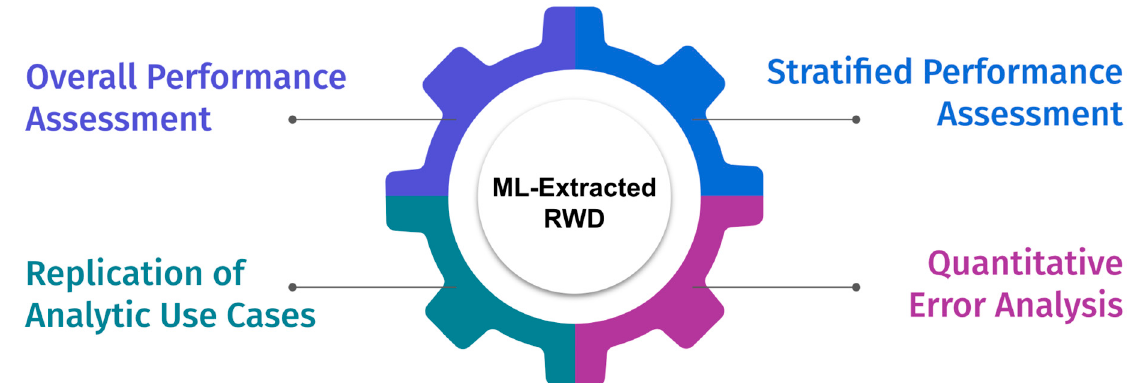
Figure 1. Evaluation Framework.